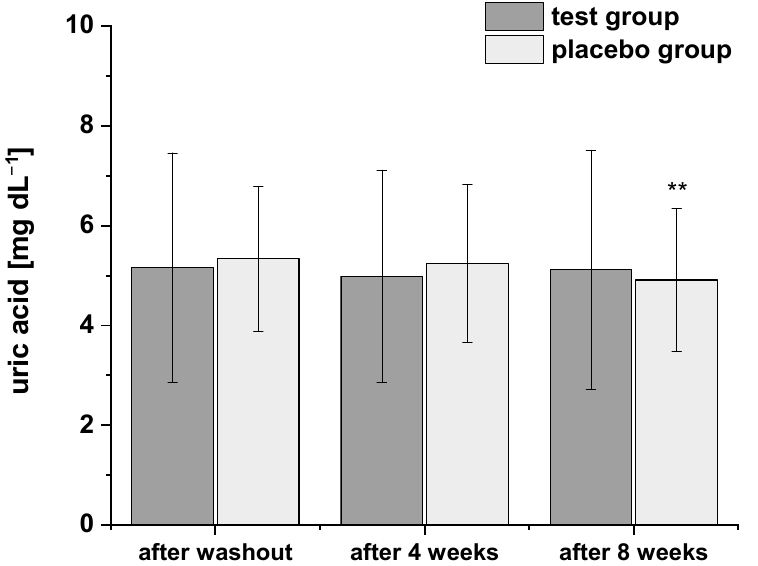
Figure 3. The plasma uric acid concentrations after the washout period, after four and eight weeks of intervention. Data are expressed as means ± SD. Significant differences in comparison to the washout period: ** p < 0.01. period: ** p <